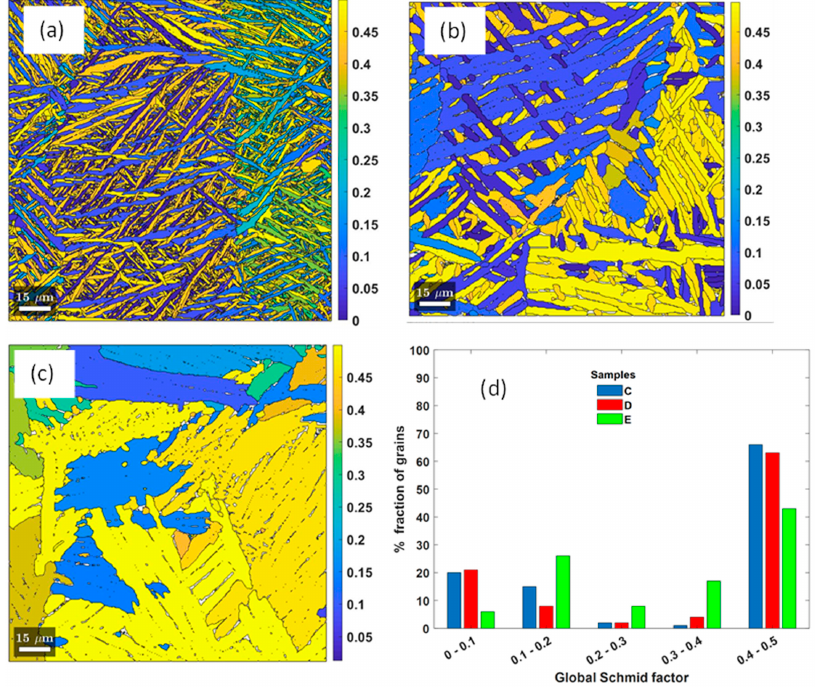
Figure 8. Typical values of the global Schmid factor for basal slip systems of the α -phase for the load applied along the build orientation in samples ( a ) C, ( b ) D and ( c ) E, while ( d ) shows the statistical distribution of the values obtained in each form of material.